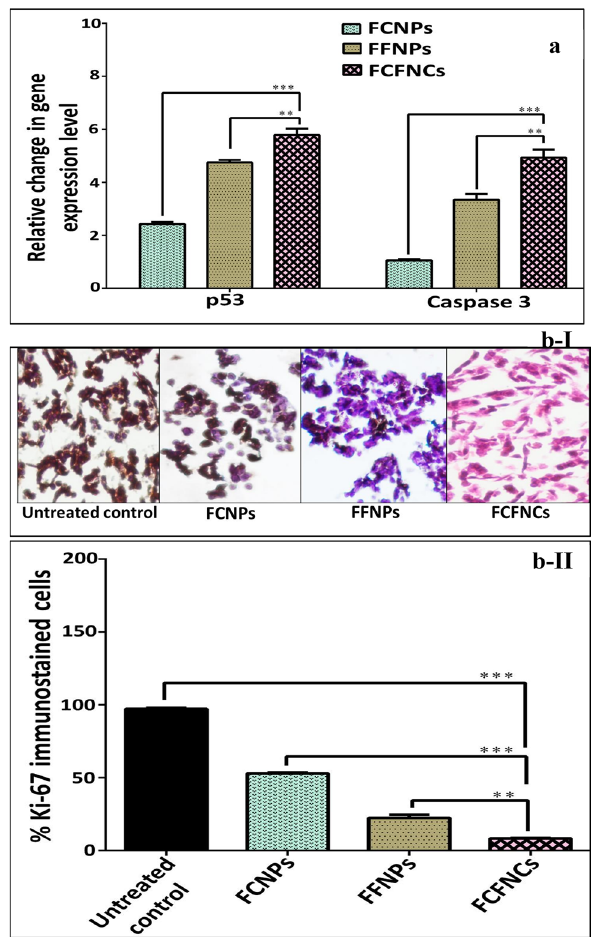
Figure 6. Impact of FCNPs , FFNPs and FCFNCs on apoptotic and proliferation markers in the treated HepG-2 cells relative to the untreated cancer cell lines. ( a ) Relative change in the gene expression of p53 and caspase 3 using QPCR. ( b-I , II ) Microscopic image for Ki-67 of the untreated and treated cancer cells (magnification × 400) with representative percentage of positive immunostaining cancer cells. All values were expressed as mean ± SEM. FCFNCs were compared with all other treatments with significance at *p < 0.05, **p < 0.005, ***p <